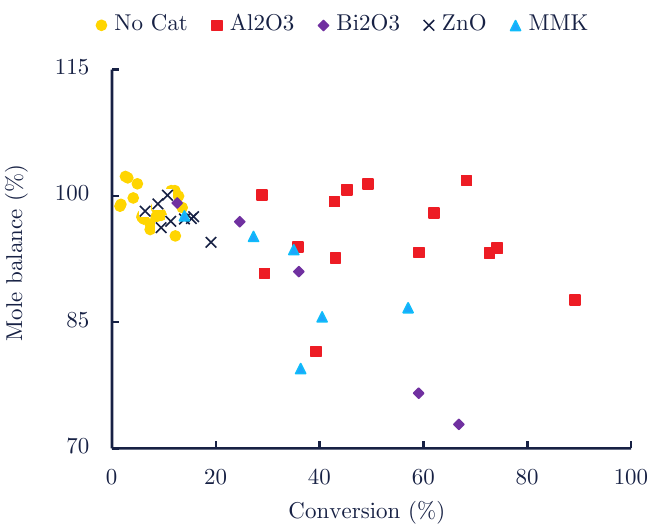
Figure 4. Aromatic mole balance of the quantifiable compounds vs. MPC conversion in the autoclaves (variable cat: feed ratio with a set temperature of 200 °C ).